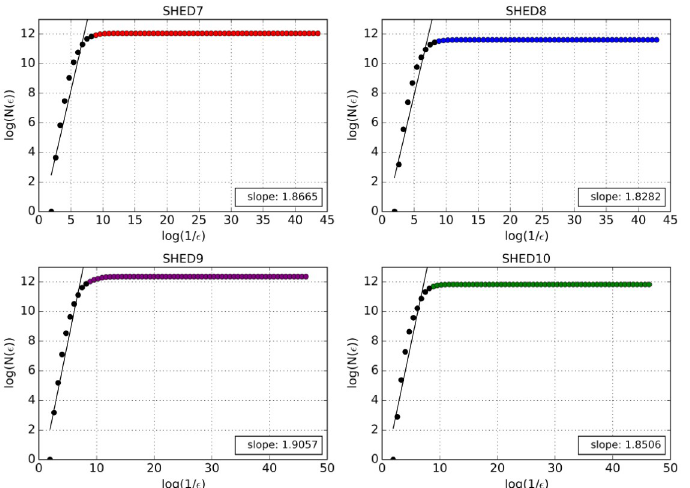
Fig 6. Slope calculation of the ID of each dataset. Black points represent the linear portion employed in slope calculation.